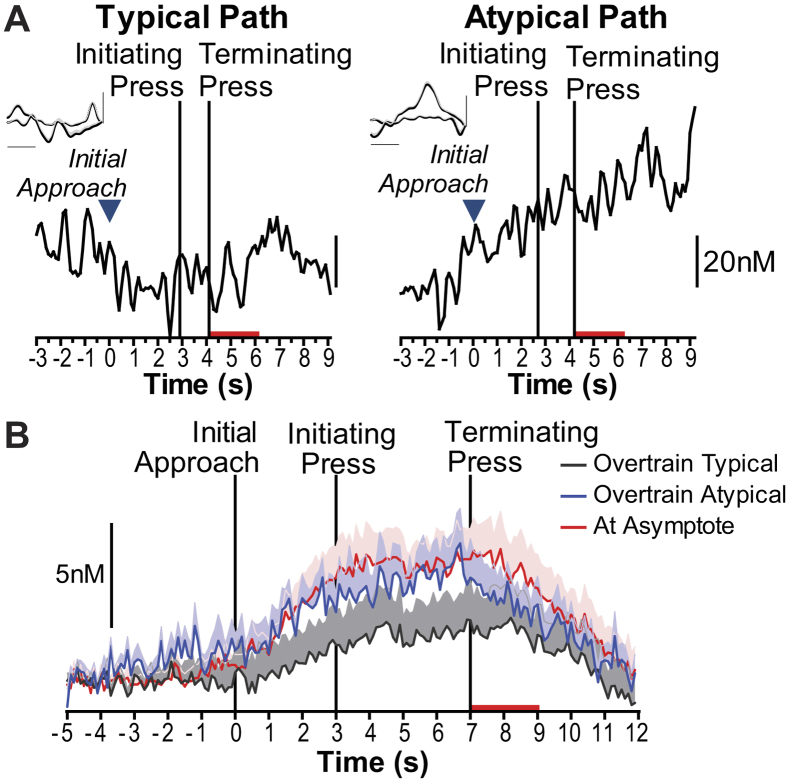
Dopamine signals following extended training during stereotyped v. atypical sequence paths.(A) Representative example of continuous (unaveraged, nonconcatenated) dopamine concentration v. time traces for individual sequence performance from the last training session from the same rat for a stereotypical and atypical sequence path trial. Blue arrows: time of initial approach towards initiating lever. Insertion of the terminating lever occurs immediately following the initiating lever press. Red bars: time of reward delivery and consumption. Insets: Averaged CVs taken at 1-s intervals starting 2 s prior to the initiating press and extending 7 s after this press; shading reflects +1 within-sample SEM; x-axis scale bar: 0.5 V, y-axis scale bar: 0.5 nA. (B) Average dopamine concentration v. time trace during action sequence performance at asymptotic performance and during overtraining divided for typical v. atypical path sequences. Shading reflects between-subject SEM.